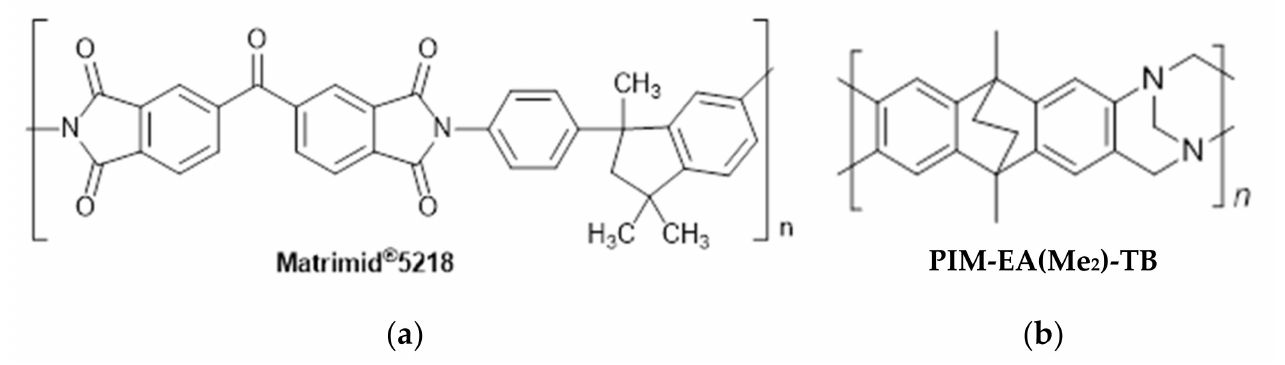
Figure 1. ( a ) Chemical structures of Matrimid ® 5218 and ( b ) PIM-EA(Me 2 )-TB.